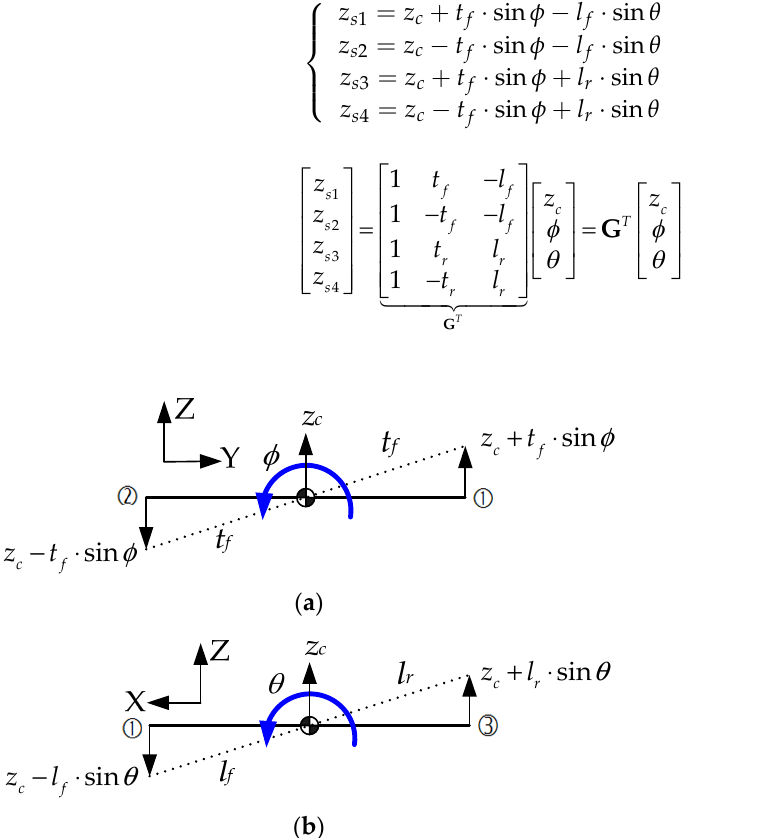
Figure 4. Roll and pitch motions of the sprung mass. ( a ) Roll motion (front view); ( b ) Pitch motion (side view).